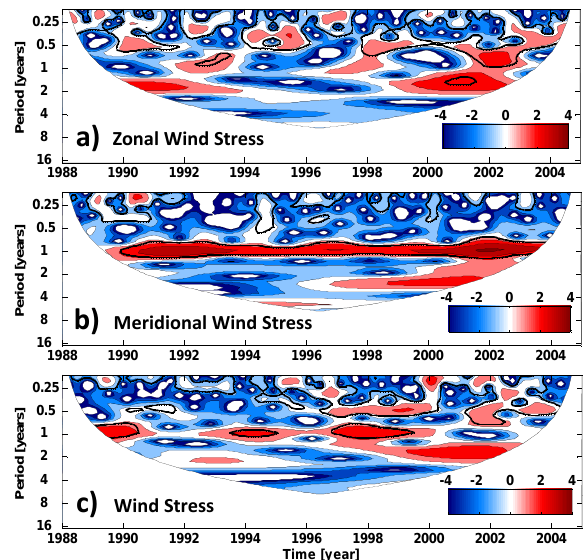
Fig. 11. The wavelet power spectrum of Weddell Sea sector (a) zonal wind stress, (b) meridional wind stress, (c) and wind stress time series using the Morlet wavelet. The white area is the cone of influence, where zero padding has reduced the variance. The black thick contour encloses regions where confidence levels were greater than 90% for a red-noise process with a lag-1 coefficient of 0.72. The units (colourbar) are the energy in log 2 form.